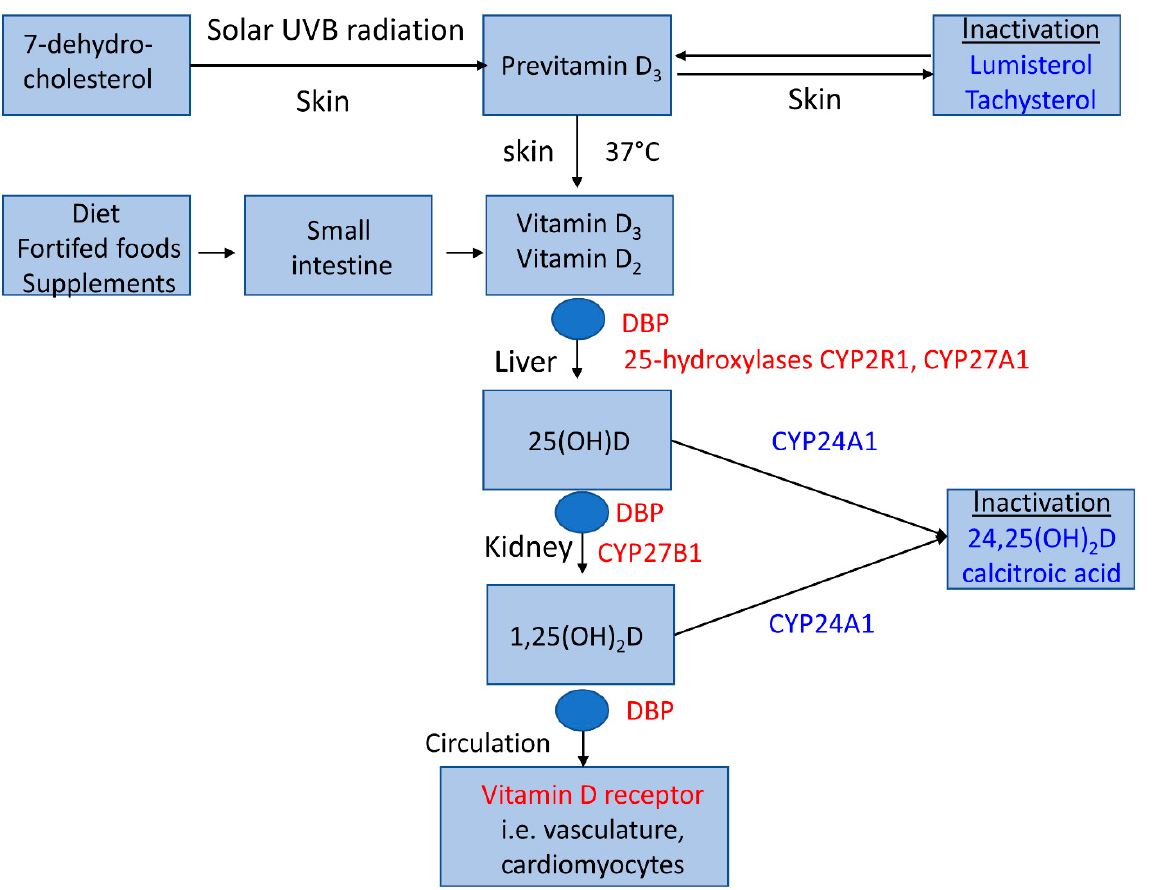
Figure 1. Major metabolic pathways of vitamin D in the human body. Previtamin D 3 is produced in the skin by solar UVB radiation (290–315 nm) from 7-dehydrocholesterol and isomerized by a thermal reaction into vitamin D 3 or reversely metabolized to vitamin D-inactive substances such as lumisterol and tachysterol. Vitamin D 3 (cholecalciferol) or vitamin D 2 (ergocalciferol) can also be ingested orally from native foods (fish, dairy, mushrooms), vitamin D-fortified foods, or supplements. Both cutaneously synthesized and orally ingested vitamin D are metabolized by hepatic 25-hydoxylases into 25-hydroxyvitamin D (25(OH)D), the main 25-hydroxylase being a microsomal enzyme (gene CYP2R1). A renal 1 α - hydroxylation of 25(OH)D results in the formation of the physiologically active vitamin D hormone, 1,25-dihydroxyvitamin D (1,25(OH) 2 D). After release into circulation, 1,25(OH) 2 D can be taken up by various target tissues and exerts its effects by vitamin D receptor-mediated processes. Vitamin D binding protein (DBP) is the major transport protein for vitamin D and its metabolites. Inactivation of vitamin D is induced by 24-hydroxylase. Anabolic molecules are highlighted in red font, and catabolic molecules in blue font.